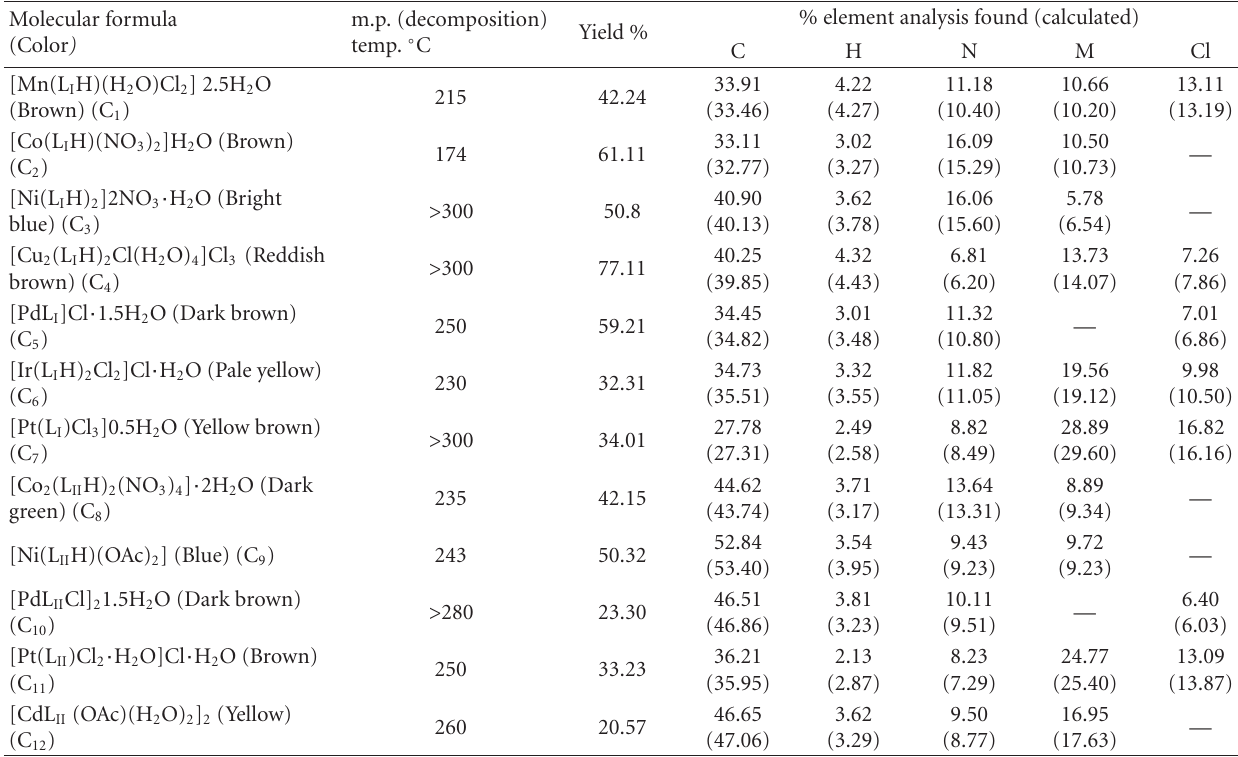
Table 1: Physical properties and analytical data of the prepared Schi ff and Mannich base complexes.